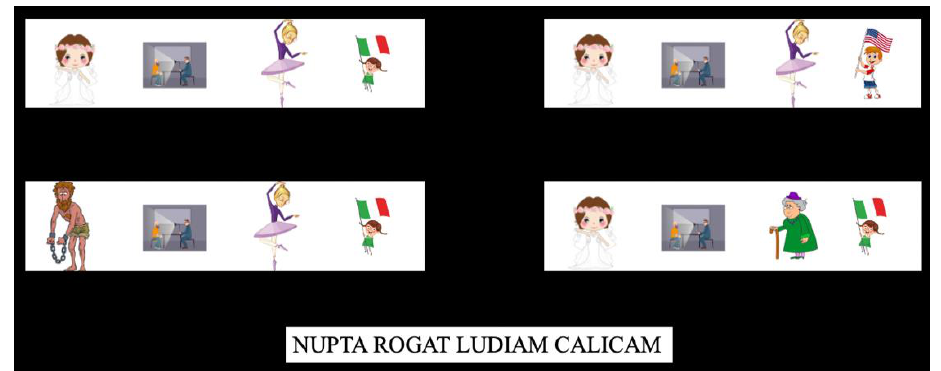
Figure 2. Example of one trial of the grammar learning phase (GLP). Participants were required to select with the mouse the series of figures that represented the correct lexical order of the sentence. ( Top left ) Correct lexical order of the sentence. ( Bottom left ) Wrong picture – lexical match in the subject position. ( Top right ) Wrong picture – lexical match in the adjective position. ( Bottom right ) Wrong picture – lexical match in the object position.